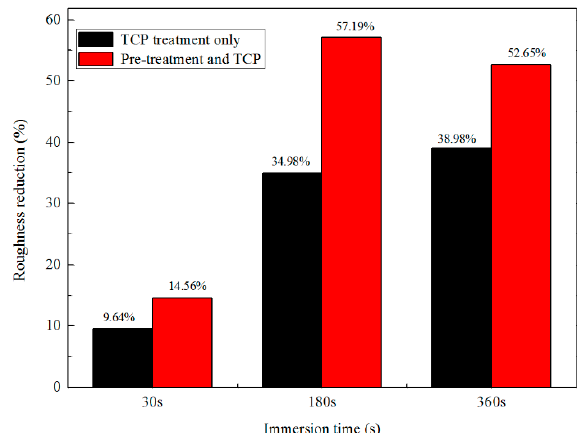
Figure 3. Roughness reduction of Zn55Al surface with two kind of treatment at different immersion periods in the TCP bath.